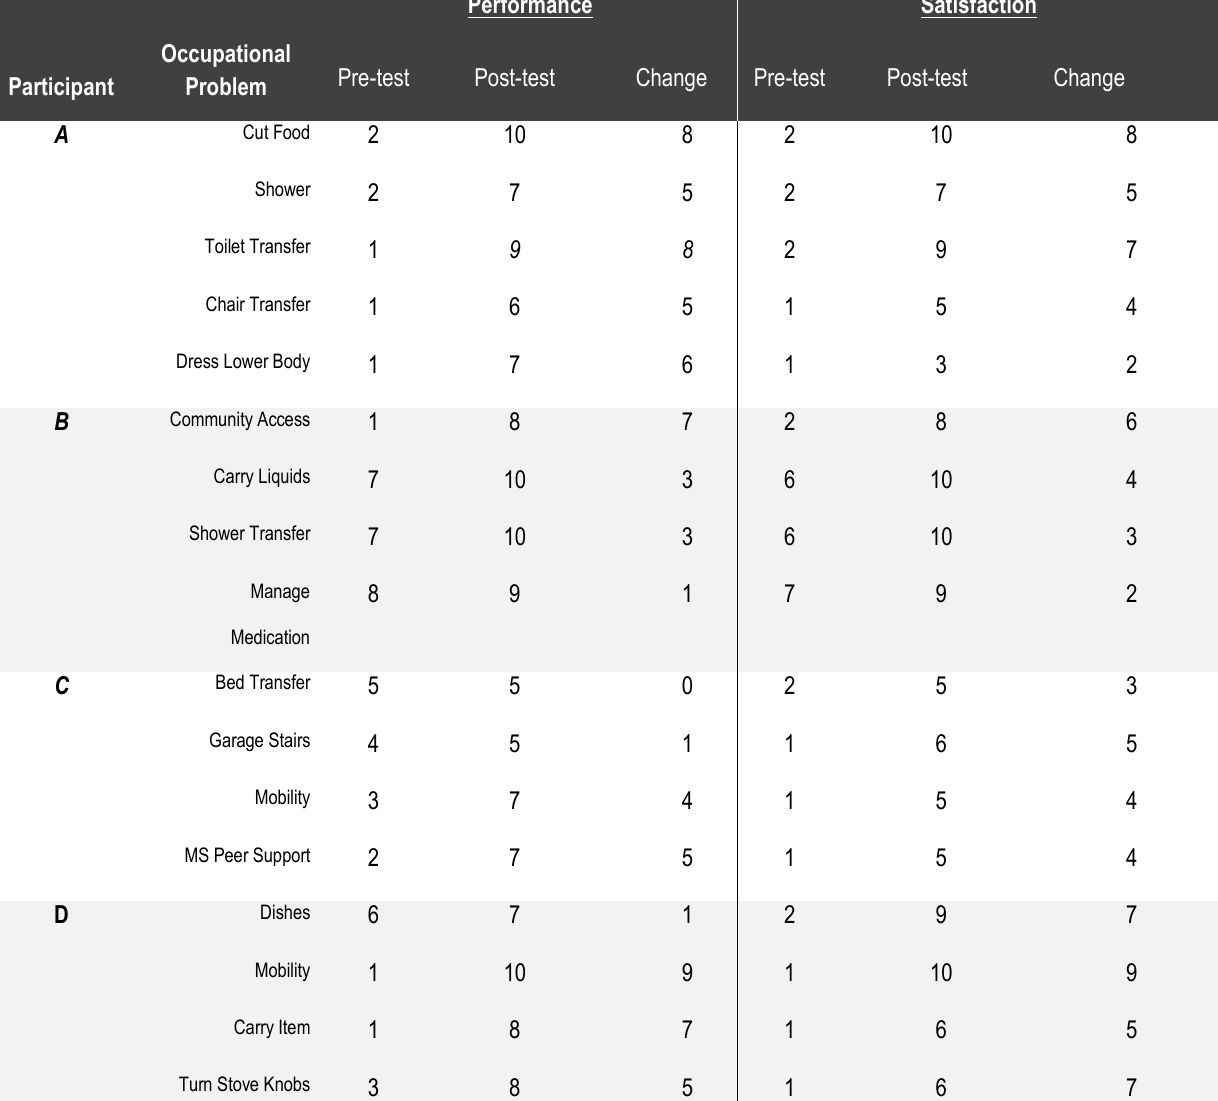
Table 2. Comparison of Pre-and Post-Intervention COPM Performance and Satisfaction Scores